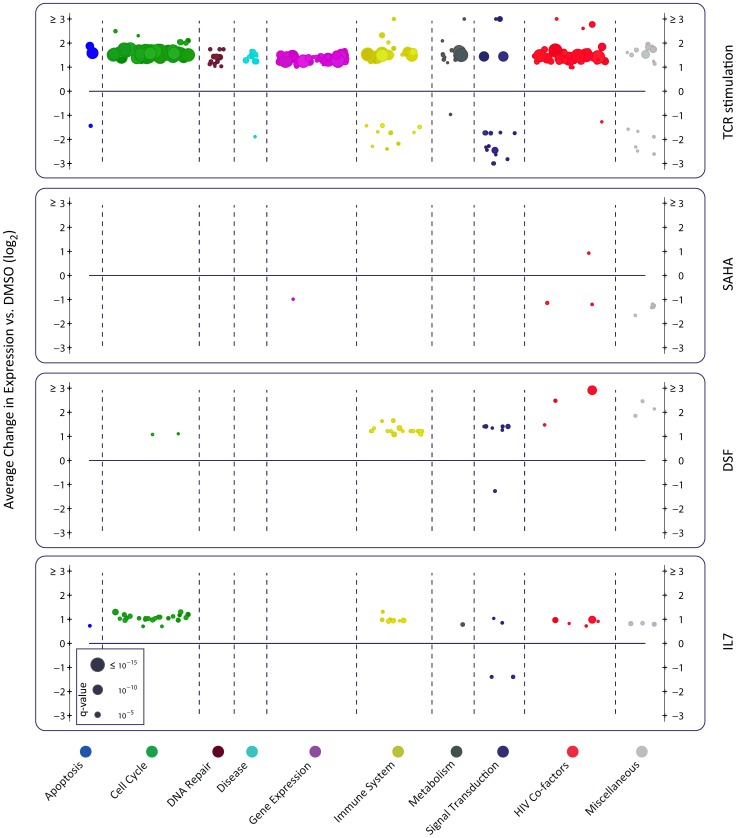
Reactivating agents fail to provide cellular environment necessary for completion of HIV life cycle.Each panel summarizes over-represented pathways among the differentially expressed genes induced by the indicated treatment. Organized under ten major categories, each individual circle represents one enriched pathway in Reactome (see methods). The size is proportional to the adjusted p-value (q-value), and the y-axis corresponds to the average effect of the differentially expressed genes within the reported pathway. Only TCR stimulation using anti-CD3/CD28 and IL-2 leads to upregulation of numerous cellular pathways, as well as upregulation of reported HIV cofactors and HIV related pathways (shown in red). AZA is not shown as no enrichment was observed.